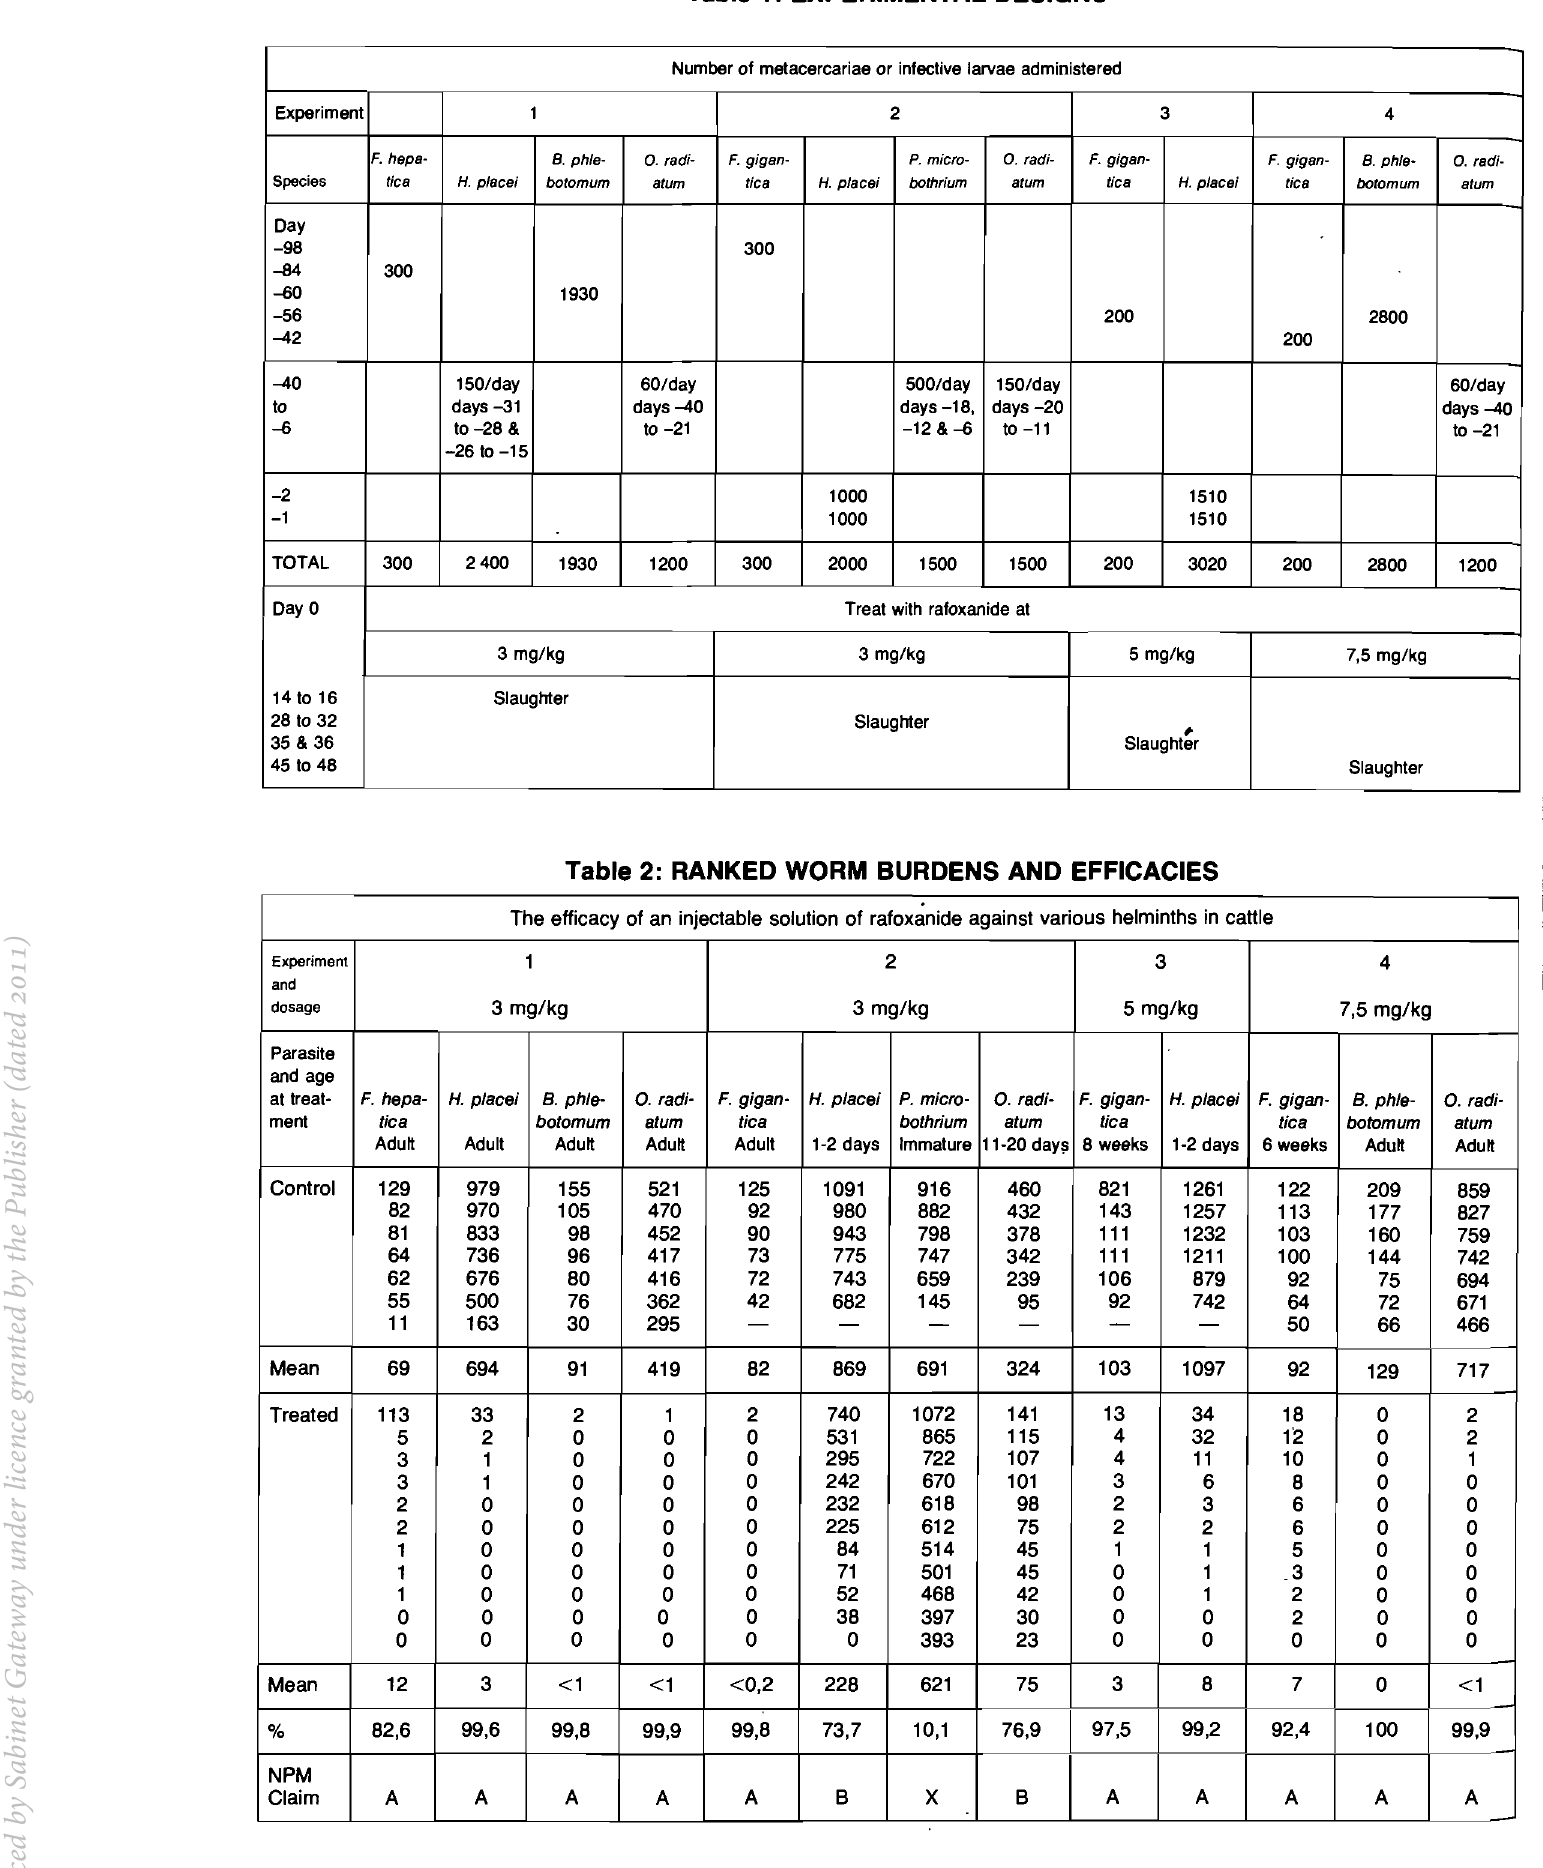
Table 2: RANKED WORM BURDENS AND